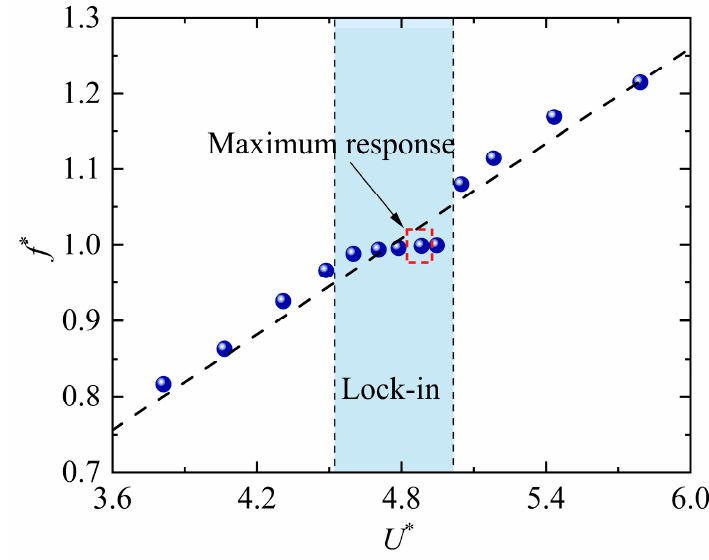
Figure 6. Variation in dimensionless frequency ( f *) versus reduced velocity ( U *). Figure 7 shows the variation in the peak factor k p with U *, in which k p = A max / A rms , where A rms is the root mean square (RMS) of the response time history. Overall, k p decreases first and then increases in the vicinity of the lock-in region, while it becomes relatively stable outside the lock-in interval. It can be seen that k p reaches a minimum value of 1.63 at U * = 4.88, which approaches the theoretical value of k p = 1.414 of a single sinusoidal process. When U * lies outside of the lock-in region, the peak factor increases significantly to around 3.5 to 4.0. These values are very close to the typical values of random processes, which indicates that the VIV response of the steel tube is similar to the random processes.